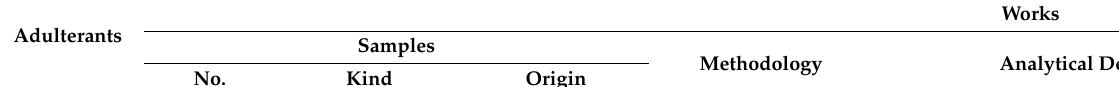
Table 3. Detecting adulterants in coconut sap, sugar, and